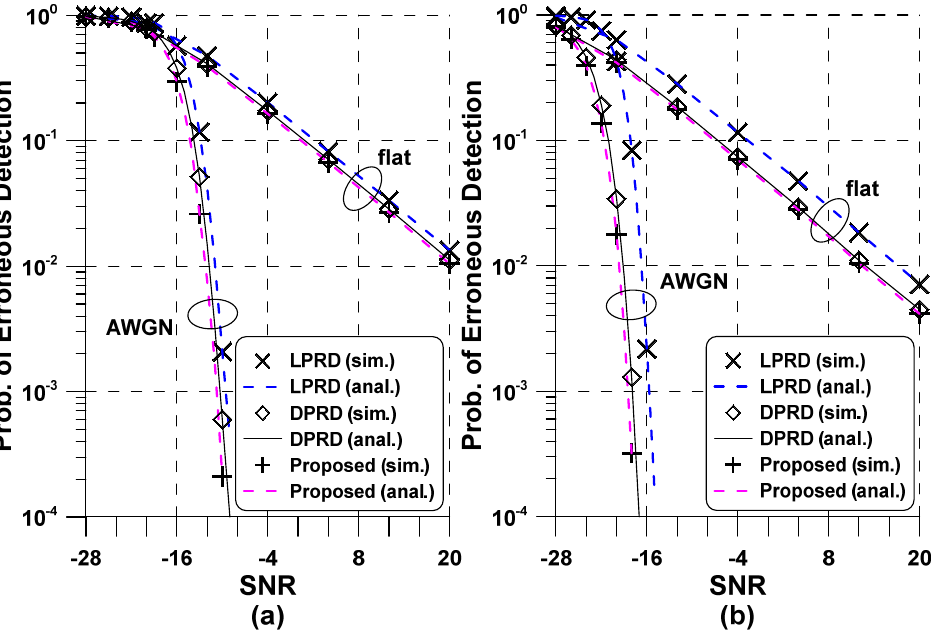
Figure 1. PED of the NSSS detectors in the AWGN and flat-fading channels: ( a ) N v = 1 ( b ) N v =